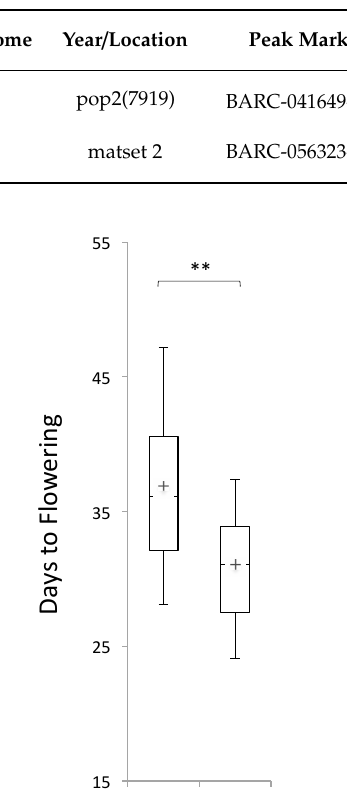
Figure 5. Flowering (R1) and maturation (R8) of the QTL R1-1 in the BC3F2 population. The BC2F6 RIL LG08-7379 carrying the G. soja allele of the QTL R1-1 peak marker BARC-056323-14257 was backcrossed with Williams 82. Twenty-eight F2 plants carrying homozygous G. max alleles (mm) and 30 F2 plants carrying homozygous G. soja alleles (ss) were grown in a greenhouse under 12 h light at the average highest day-time temperature 25 °C. The box indicates the interquartile range, the black horizontal line indicates the distribution median, and the cross indicates the distribution mean. ** p < 0.01.